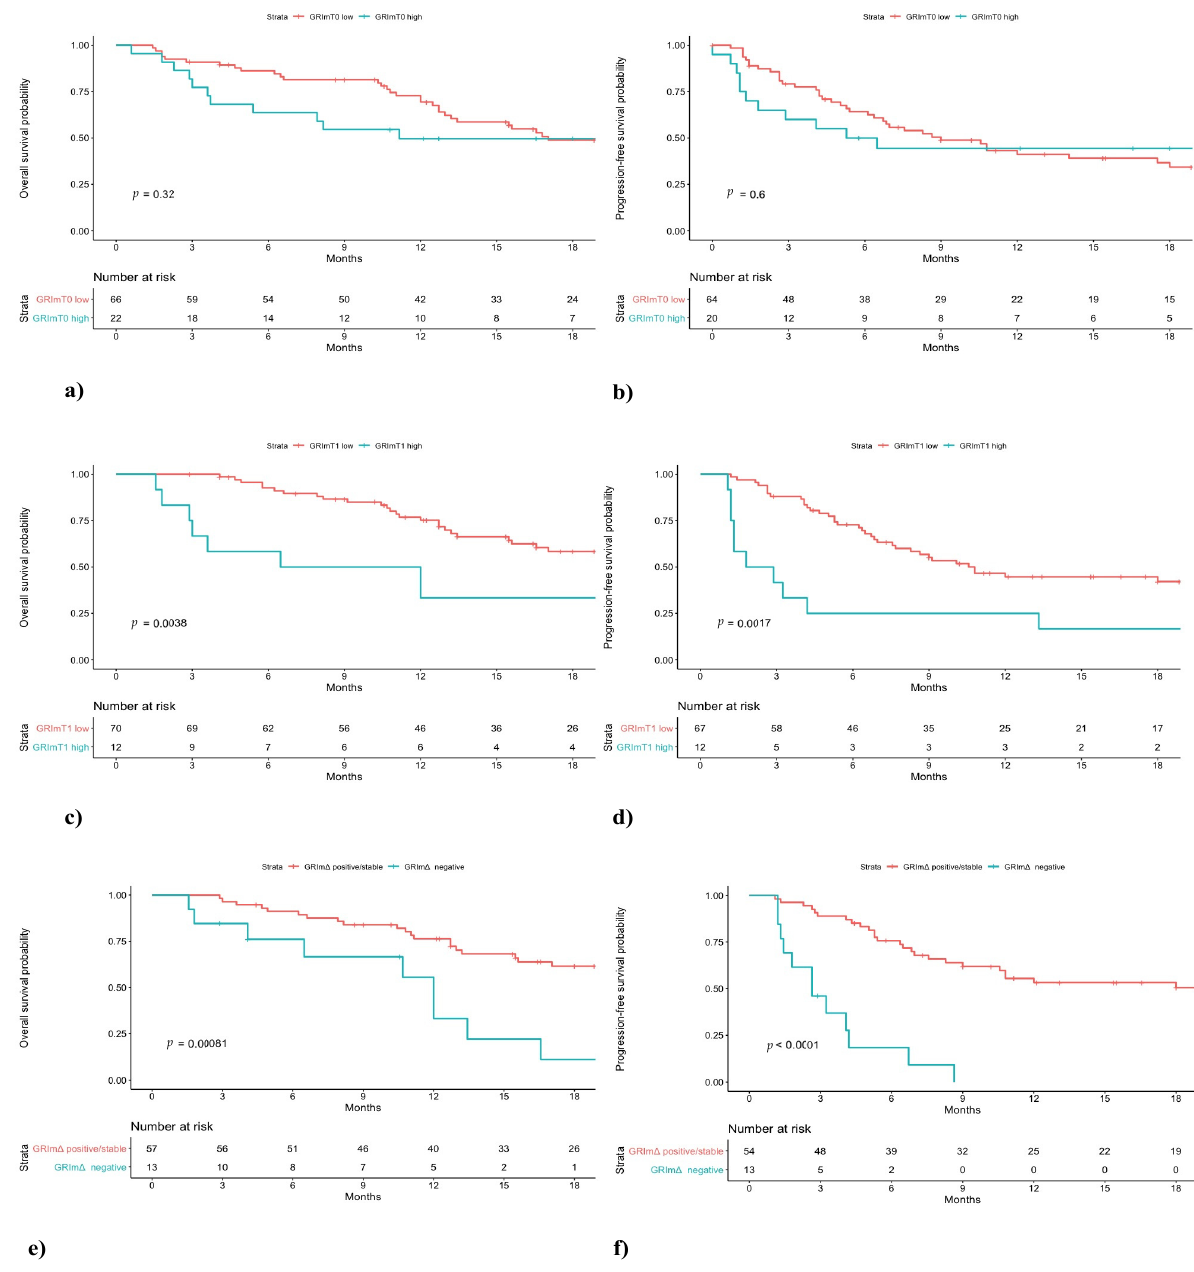
Figure 1. Overall survival (OS) and progression-free survival (PFS) of non-small cell lung cancer (NSCLC) patients treated with first-line pembrolizumab stratified by GRImT0 ( a , b ), GRImT1 ( c , d ) and GRIm Δ ( e , f ) values.